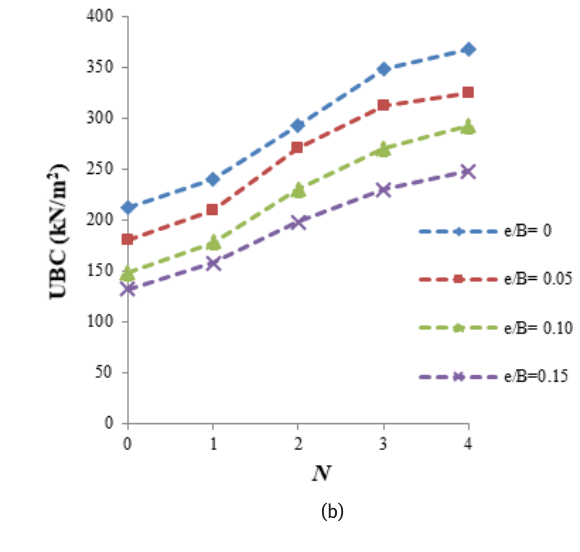
Figure 8: Variation of BCR with N at eccentric loading along the length and width